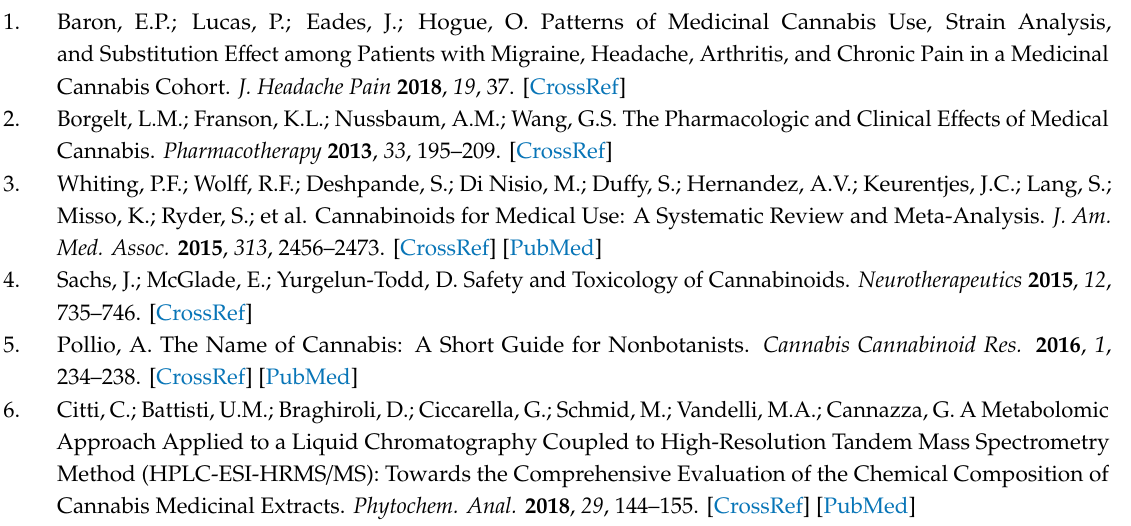
Figure S1: CBDA and CBD standard curves, Figure S2: CBD chromatogram and retention timetable, Figure S3: CBDA chromatogram and retention